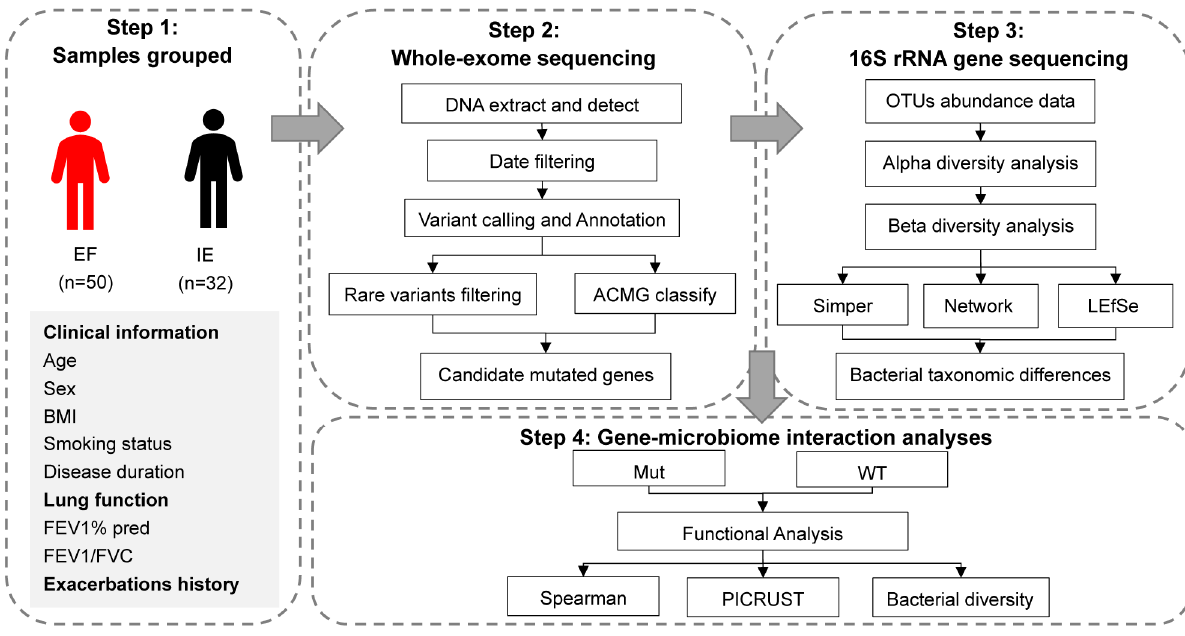
Figure 1. The workflow for this